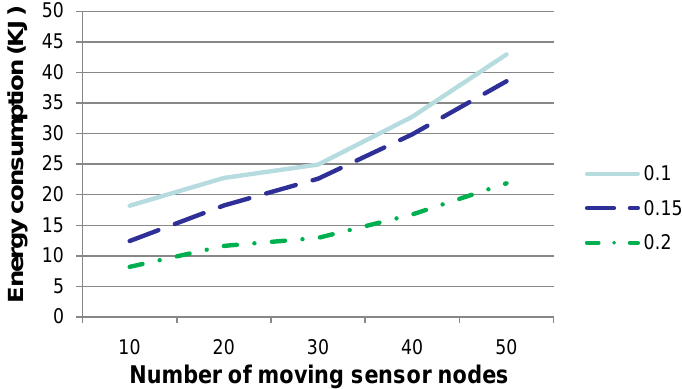
Figure 7. Comparison of energy consumption when the number of sensor nodes, which drift with the water dynamics and change their coordinates, is set to various values. This figure shows that the larger the number of sensor nodes changing their coordinates, the more energy is to be